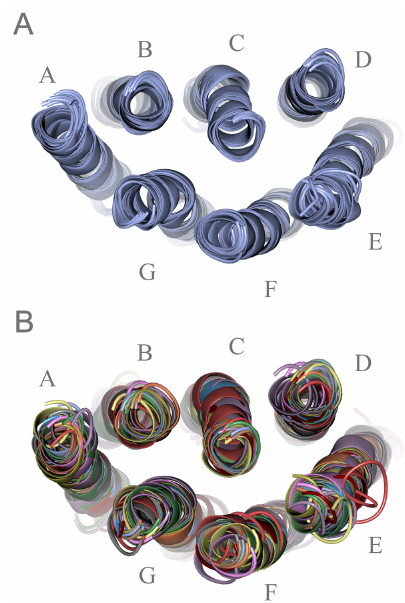
Figure 1. Graphical representation of MRs with known structure. A . 22 polypeptide chains in set 2 (dark-state wild-type bR structures) and B . 13 unique chains in set 3 (MRs of different sequences).